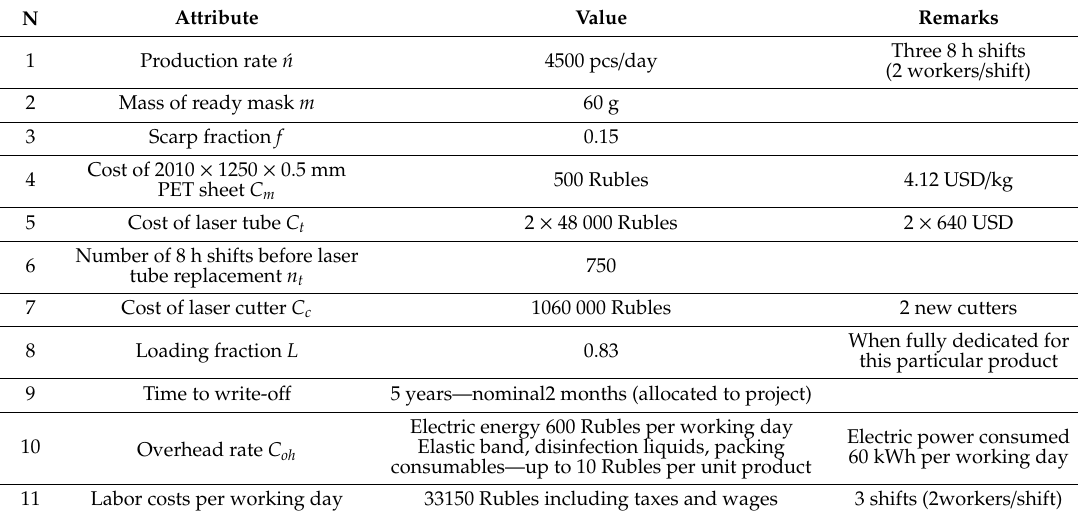
Table 2. Inputs for the cost